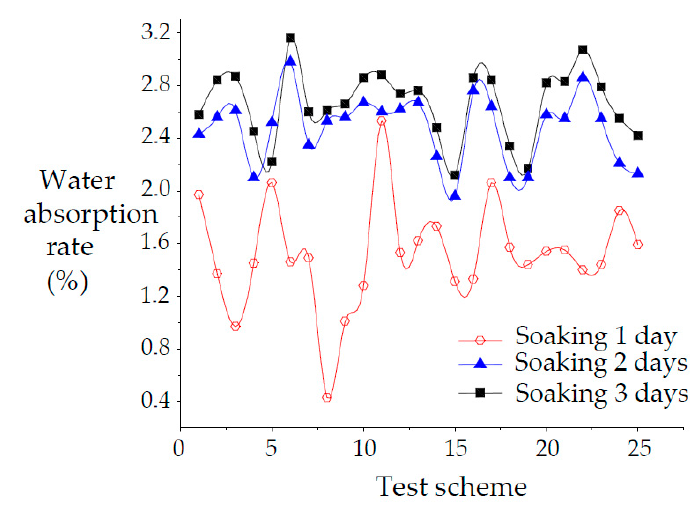
Figure 4. The trend of water absorption rate.